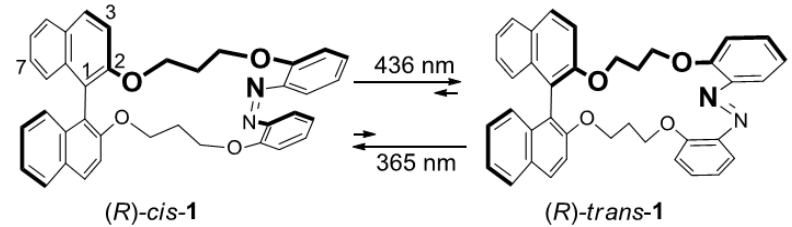
Figure 1. Photoisomerization of binaphthyl-azobenzene dyads 1 .